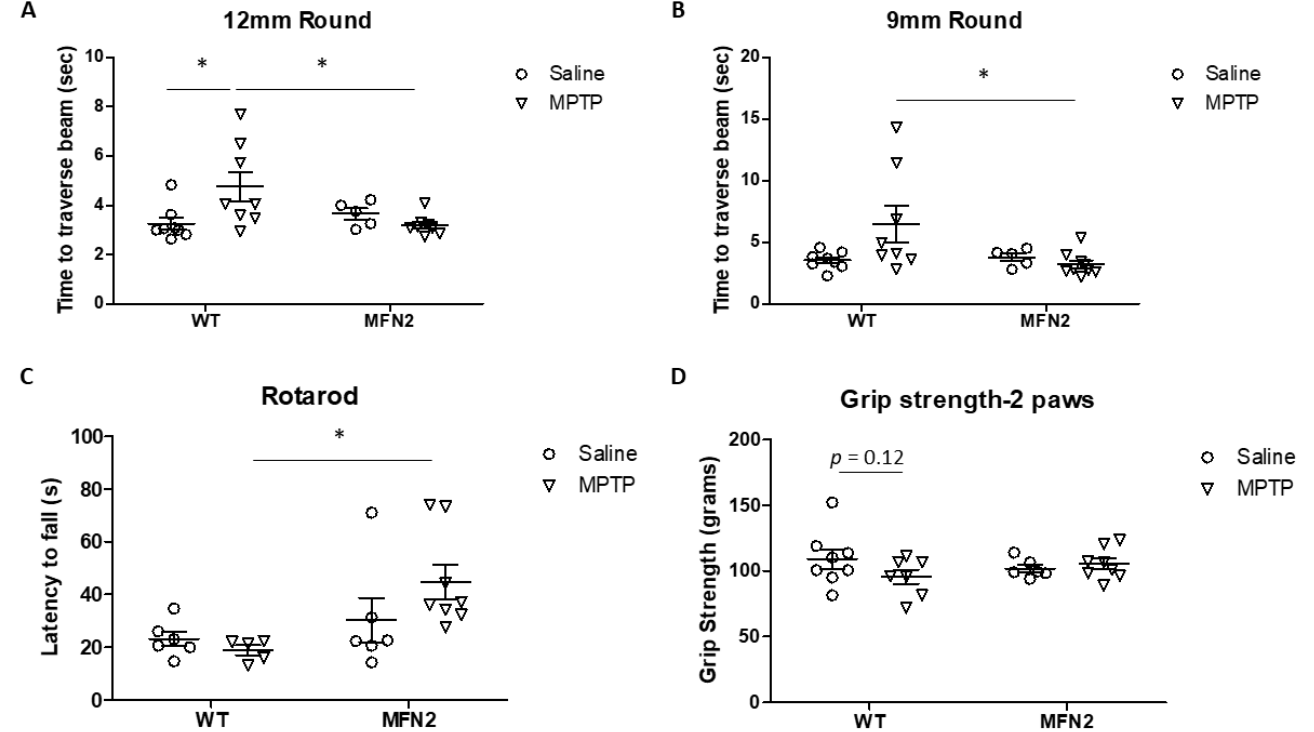
Figure 1. Mfn2 overexpression rescued MPTP-induced motor deficits. MFN2 Tg mice and WT mice were treated with MPTP (20 mg/kg) or vehicle control saline once a day for five consecutive days. Motor function was measured by the beam walking test ( A , B ) and the rotarod test ( C ) on days 6–7 after the last injection. The grip strength of two paws ( D ) was measured on day 7 before sacrifice ( n = 5–8/group; * p < 0.05 compared to the control).